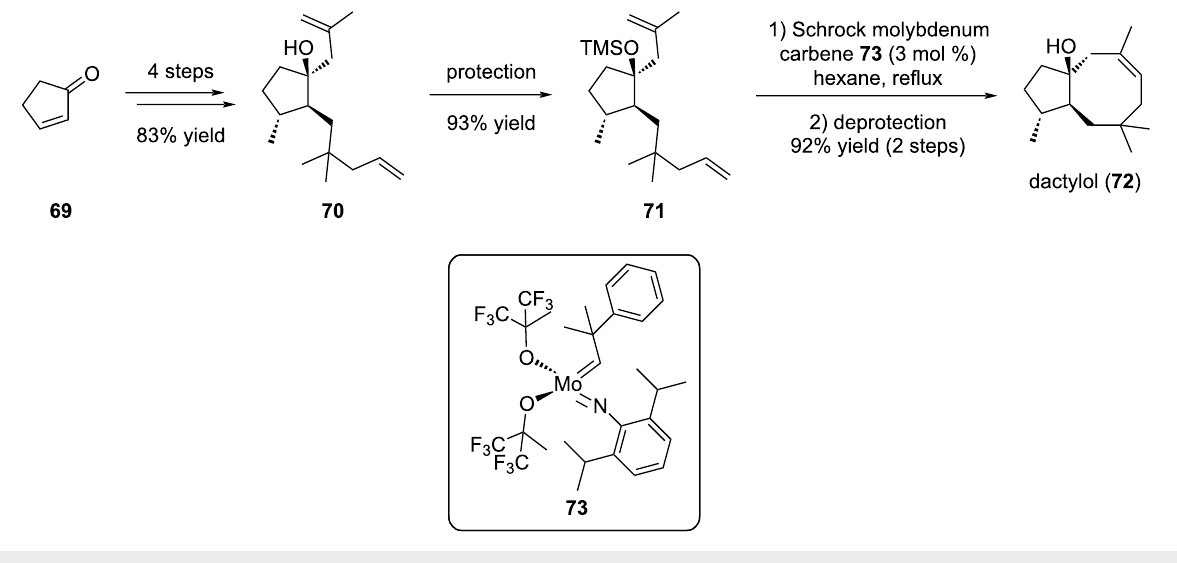
Scheme 12: Total synthesis of dactylol ( 72 ).